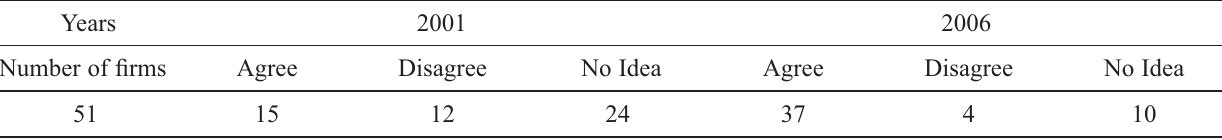
Table 10. Statement 1: “In general, information on the laws and regulations affecting my fi rm is easy to obtain”